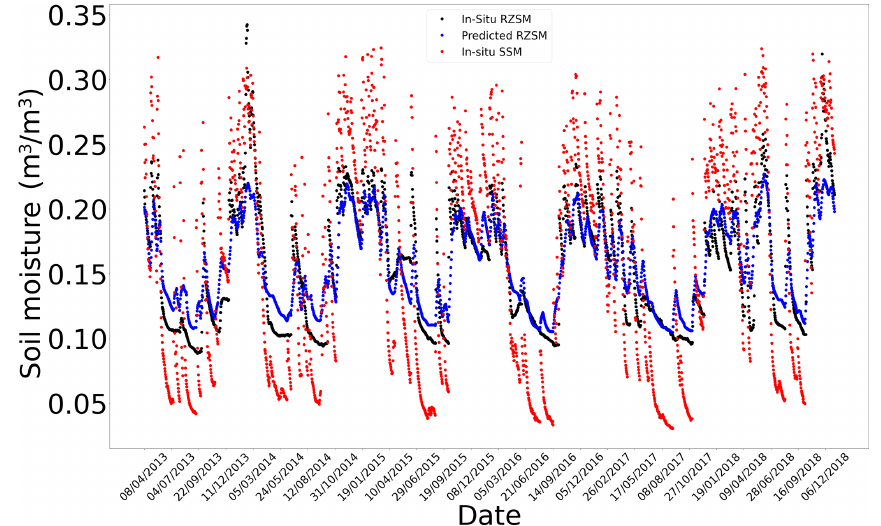
Figure E5. In situ SSM, in situ RZSM, and predicted RZSM series at station Cabrieres D’Avignon (SMOSMANIA) with model ANN_SSM.